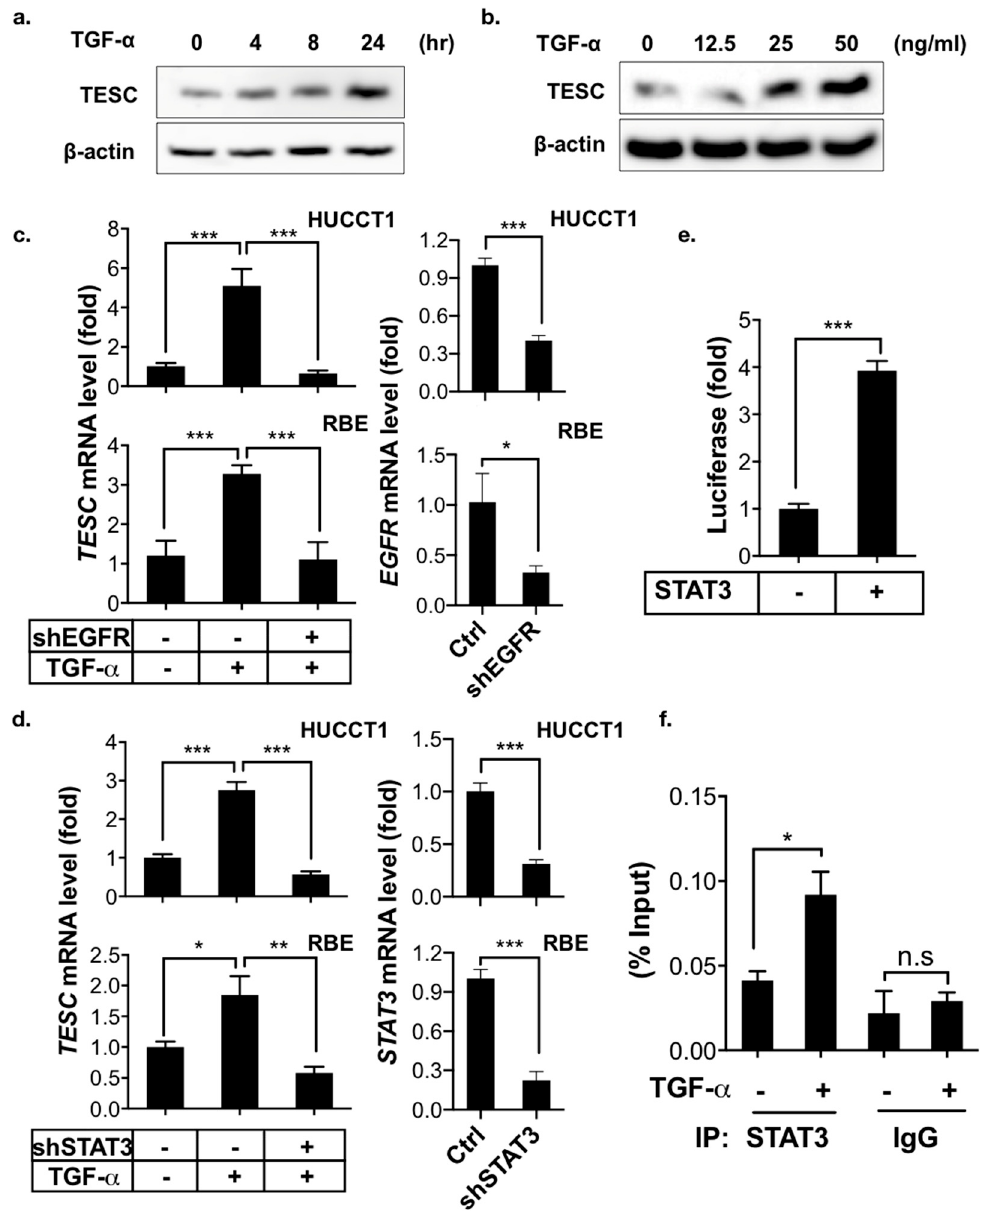
Figure 5. TESC is induced by TGF- α . ( a ) Immunoblotting for TESC in HUCCT1 cells treated with or without TGF- α (50 ng/mL) for the indicated times. β -actin was assessed as an internal control. ( b ) Immunoblotting for TESC in HUCCT1 cells treated with or without TGF- α (50 ng/mL) for the indicated concentrations for 8 h (bottom). β -actin was assessed as an internal control. ( c ) qPCR analysis of TESC expression in HUCCT1 (upper) as well as RBE (bottom) cells infected with or without shEGFR in the presence or absence of TGF- α (50 ng / mL) for 4 h. The levels of EGFR were determined by qPCR (right). * p < 0.05, *** p < 0.001. ( d ) qPCR analysis of TESC expression in HUCCT1 (upper) as well as RBE (bottom) cells infected with or without shSTAT3 in the presence or absence of TGF- α (50 ng / mL) for 4 h. The levels of STAT3 were determined by qPCR (right). * p < 0.05, ** p < 0.01, *** p < 0.001. ( e ) Luciferase reporter assay to measure the e ff ect of STAT3 on TESC promoter activity in HEK293T cells transfected with the pGL3- TESC promoter reporter plus or minus STAT3 cDNA. *** p < 0.001. ( f ) ChIP analysis of STAT3 binding to the TESC promoter. HUCCT1 cells treated with or without TGF- α (50 ng / mL) under serum-free conditions for 4 h were subjected to ChIP with an antibody against STAT3, followed by qPCR to assess the binding of STAT3 on the TESC promoter. * p < 0.05, n.s.: no significance.